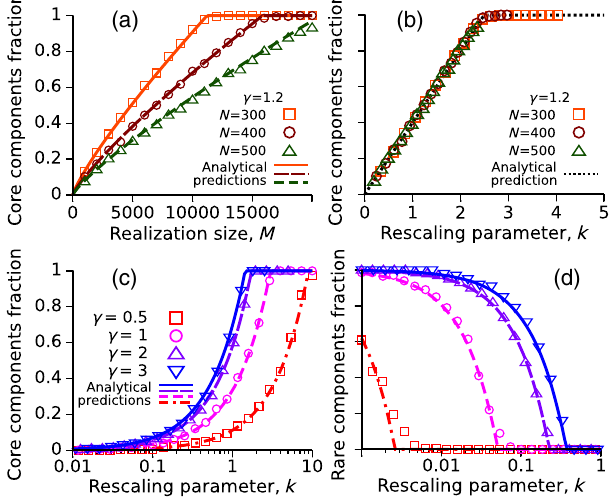
FIG. 5. Scaling of the distribution of shared components and fraction of rare and core components. (a) The fraction of core components (defined by the occurrence threshold o > θ c ¼ 0 . 95 ) for a power-law component frequency distribution with exponent γ ¼ 1 . 2 , plotted as a function of component size M for three values of realization number N . (b) Collapse of the curves shown in (a) when plotted as a function of the rescaled parameter k , defined in Eq. (11). (c),(d) Fraction of core and rare ( o < 0 . 05 ) components plotted as a function of k for different values of γ . For sufficiently large k (i.e., typically when M dominates over N ), the fraction of core components saturates to 1. Conversely, the fraction of rare components drops to zero for increasing k . Symbols refer to numerical simulations of the random-sampling model, while the lines are the theoretical predictions of Eq.